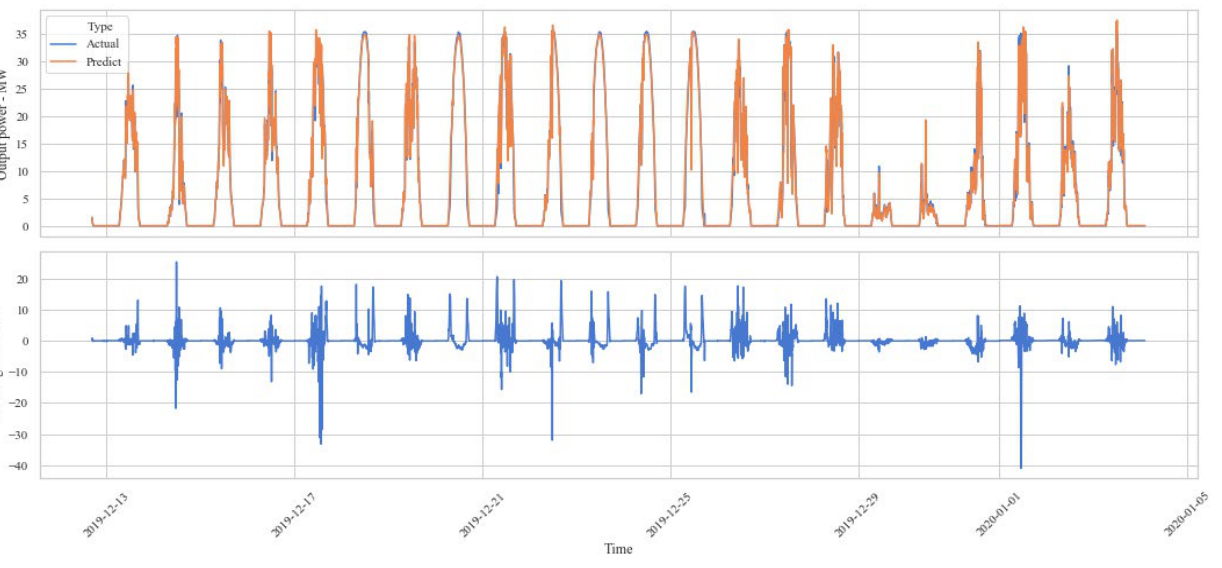
Figure 8. Detail 5-minute result with historical meteorological